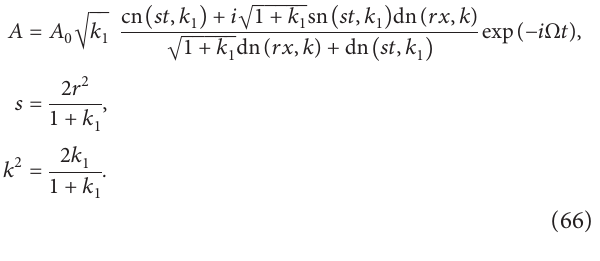
� − 2 π . (b) η 0 . (a) η 0 3 3